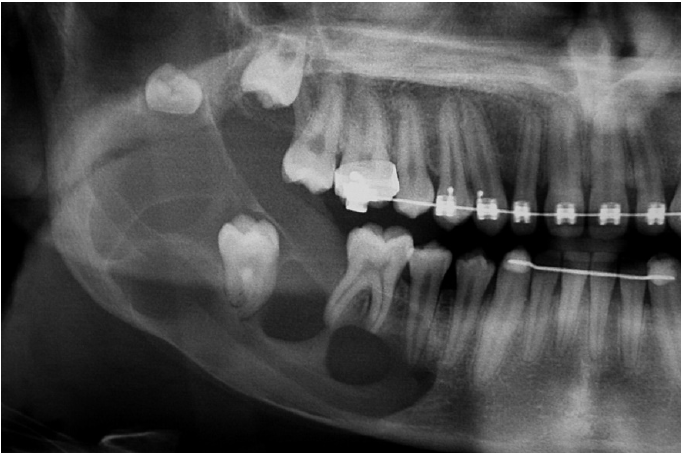
Figure 1. Panoramic radiography: A well-defined multiloculated radiolucent lesion involving impacted mandibular right second molar.